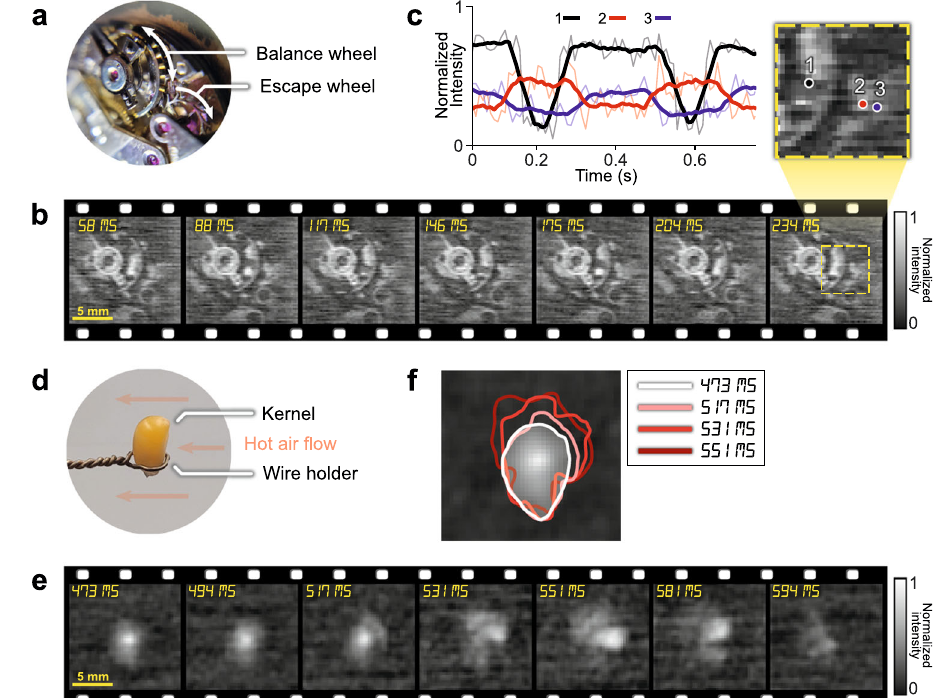
Fig. 4 | SPI-ASAP in re fl ection mode. a Photo of the internal components of the mechanical watch. b Selected frames of the running mechanical watch movement imaged at 103 fps. c Time evolution of the intensity of the three selected pixels (marked in the expanded inset from ( b )), illustrating the approximate 2.5Hz motion of the balance wheel and the 5.0Hz intermittent motion of the escape